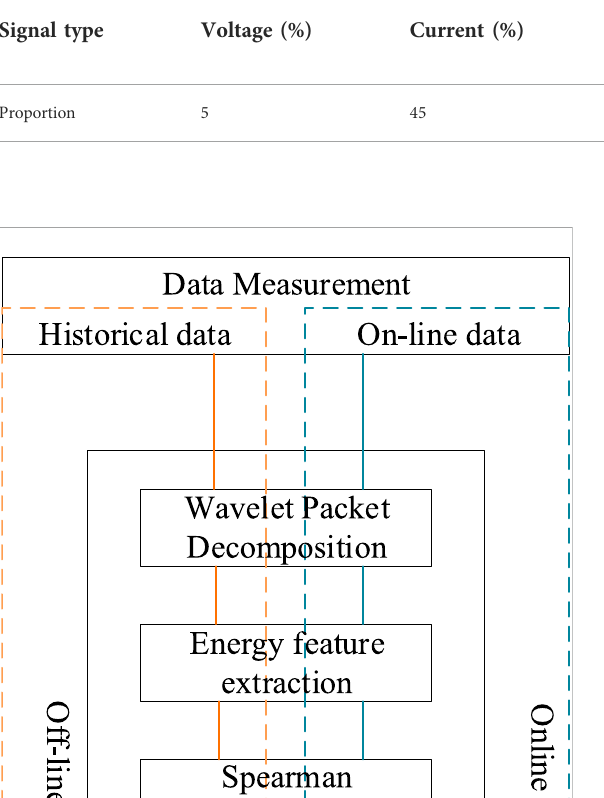
TABLE 2 Sr energy contribution.